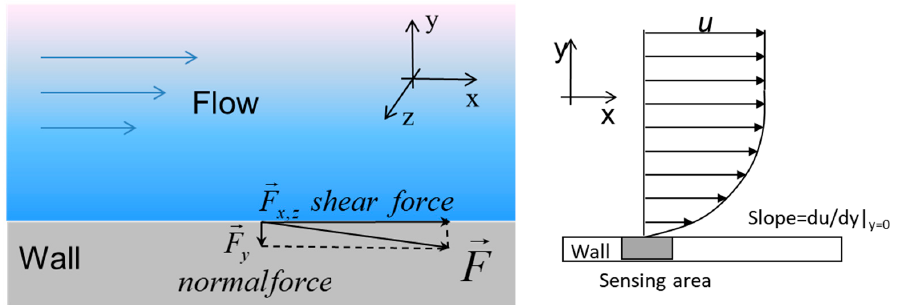
Figure 2. The mechanism of formation of shear stresses from the interaction of the flow with the wall.